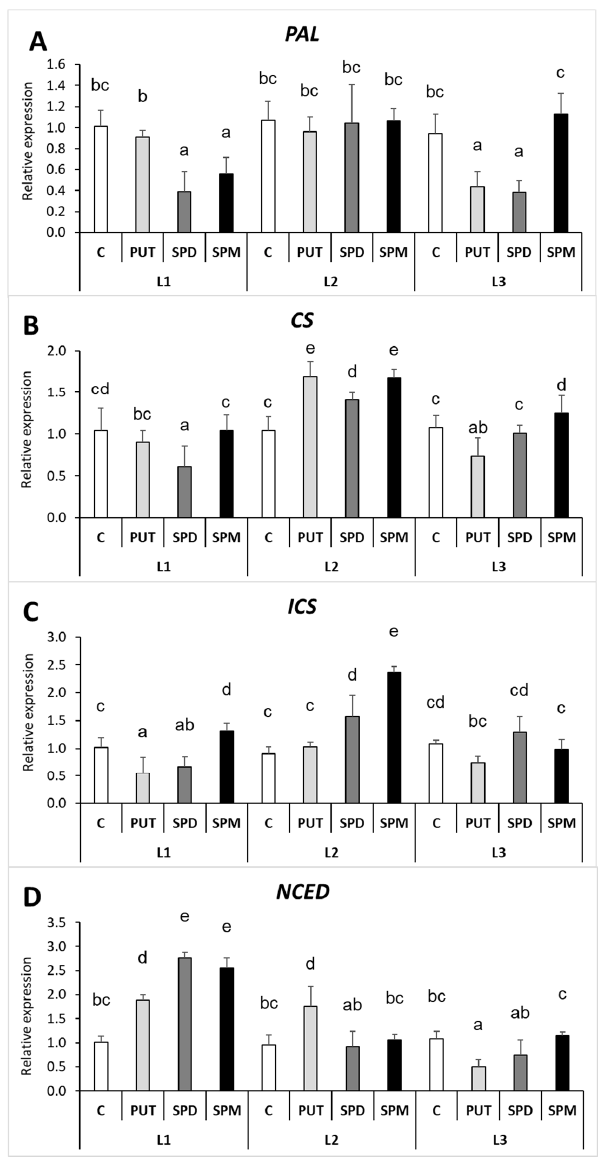
Figure 12. Effect of different light intensities on the gene expression levels of phenylalanine-ammonia-lyase ( A ) ( PAL ), chorismate synthase ( B ) ( CS ), isochorismate synthase ( C ) ( ICS ) and 9-cis- epoxycarotenoid dioxygenase ( D ) ( NCED ) in the roots of plants grown under 16 h/8 h day/night light period with different light intensity conditions: 500 (elevated light: L1), 250 (medium light: L2) and 50 (low light: L3) μ mol m 2 s − 1 LED light after 7 days of 0.3 mM exogenous putrescine (PUT), spermidine (SPD) or spermine (SPM) treatments or without any treatment (C). Data represent mean values ± SD. Different letters indicate significant differences at p ≤ 0.05 level, among all the values of the given compounds.